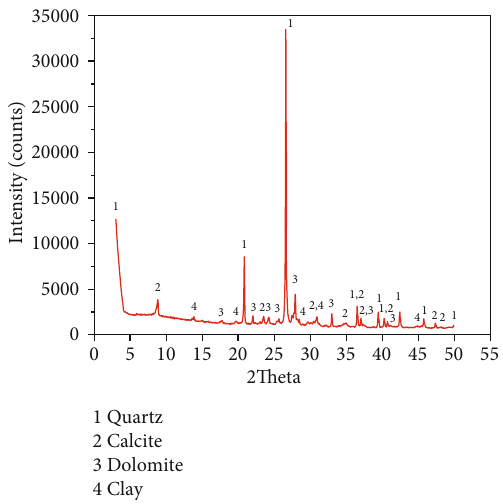
Figure 2: X-ray di ff raction analysis of whole rock.